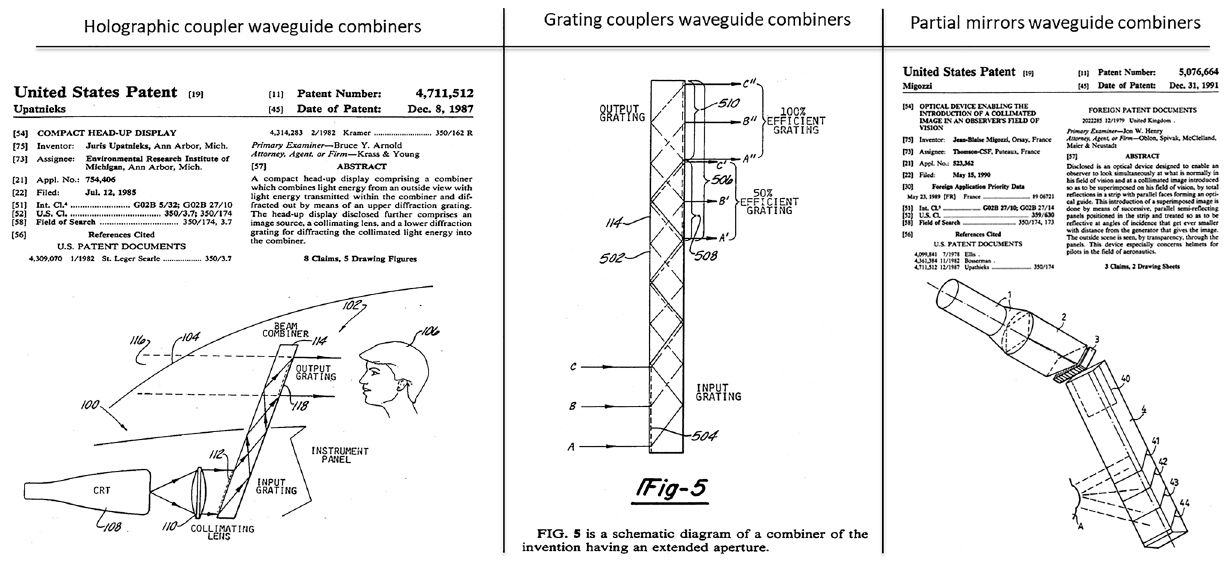
Figure5: (a)Originalwaveguidecombinerpatentsincludingholographic(1987),(b)surfacereliefgrating (1989),and(c)partialmirrors(1991) for HUD and HMD